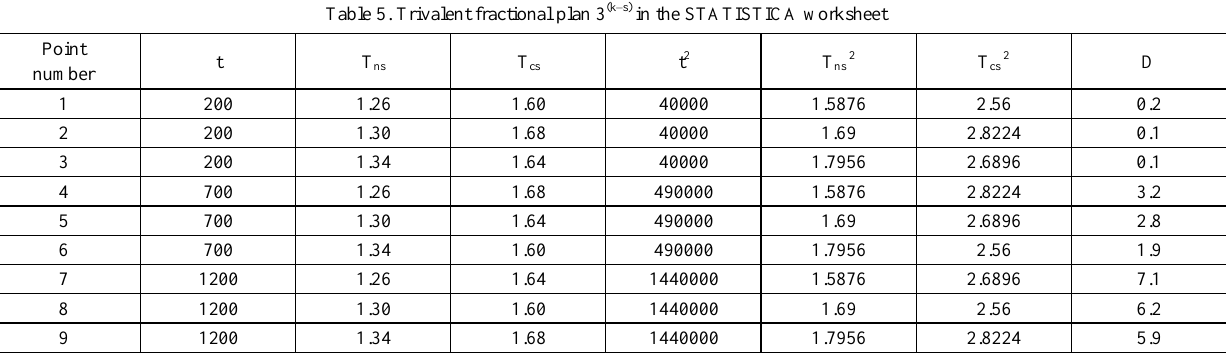
Table 5. Trivalent fractional plan 3 (k–s) in the STATISTICA worksheet